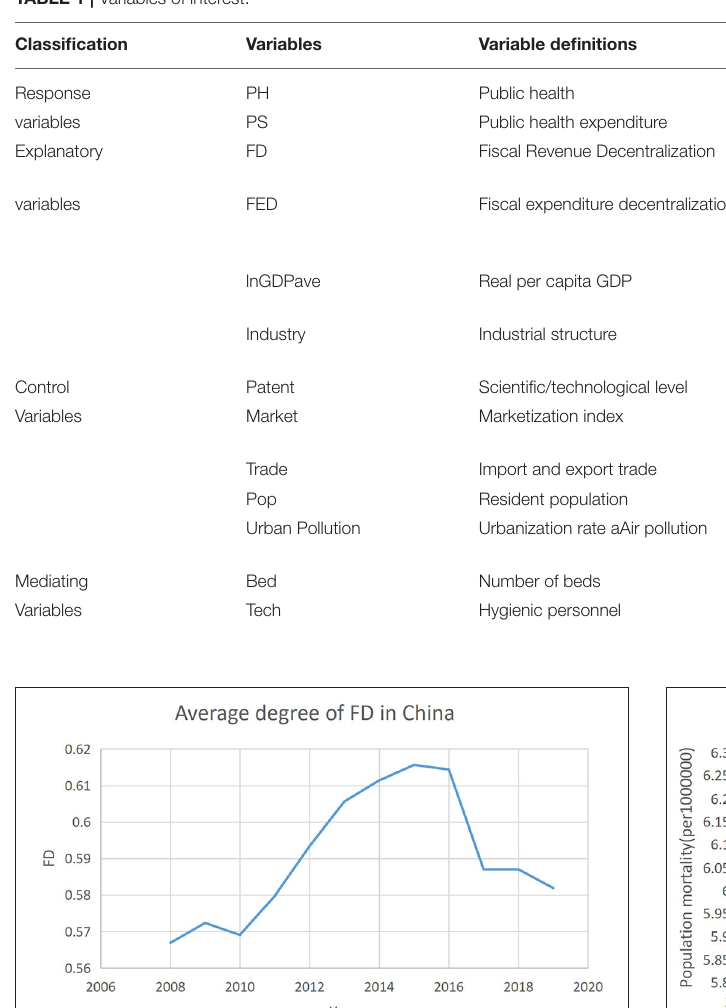
TABLE 1 | Variables of interest.